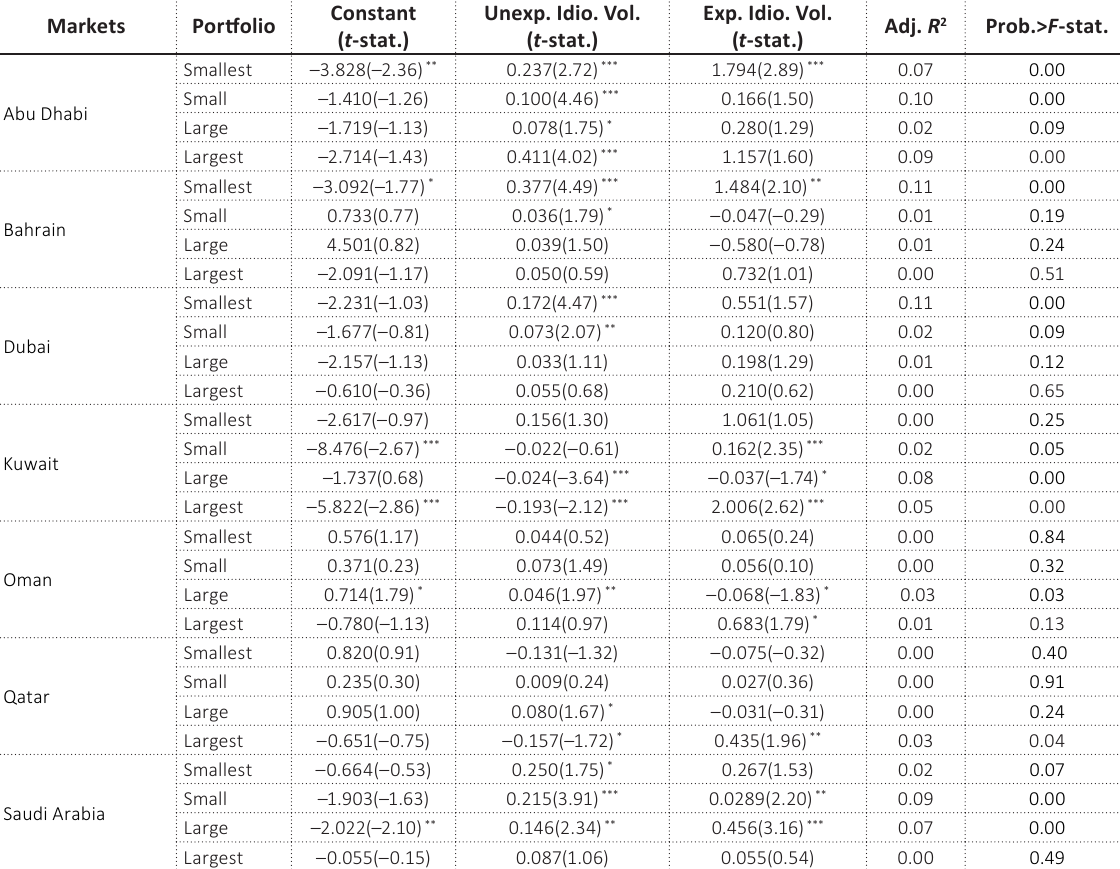
Table 3. Impact of expected and unexpected idiosyncratic volatility on size-portfolio returns Markets